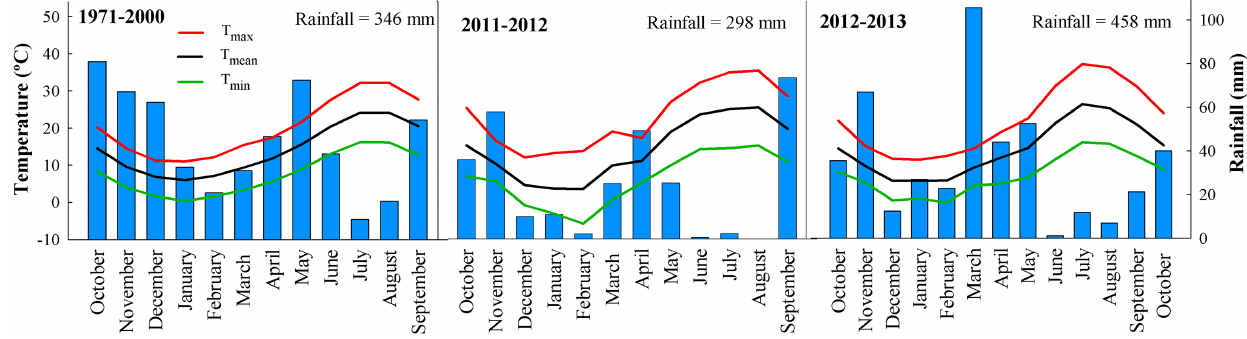
Figure 1. Monthly rainfall (bars) and average maximum, mean and minimum temperatures from 1971 to 2000 and during the two experimental seasons at Aranjuez (Madrid, Spain).